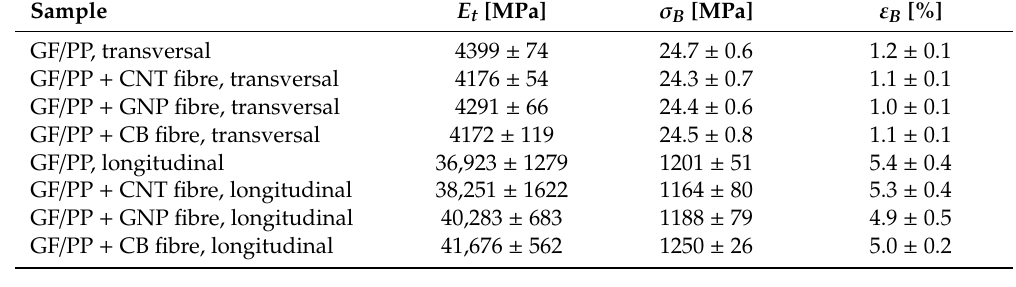
Table 3. Mechanical properties of GF / PP (50 / 50 vol.%) composites with an embedded nanostructured fibre bundle (CNT, GNP, CB) (the values given represent mean values of 7 measurements).